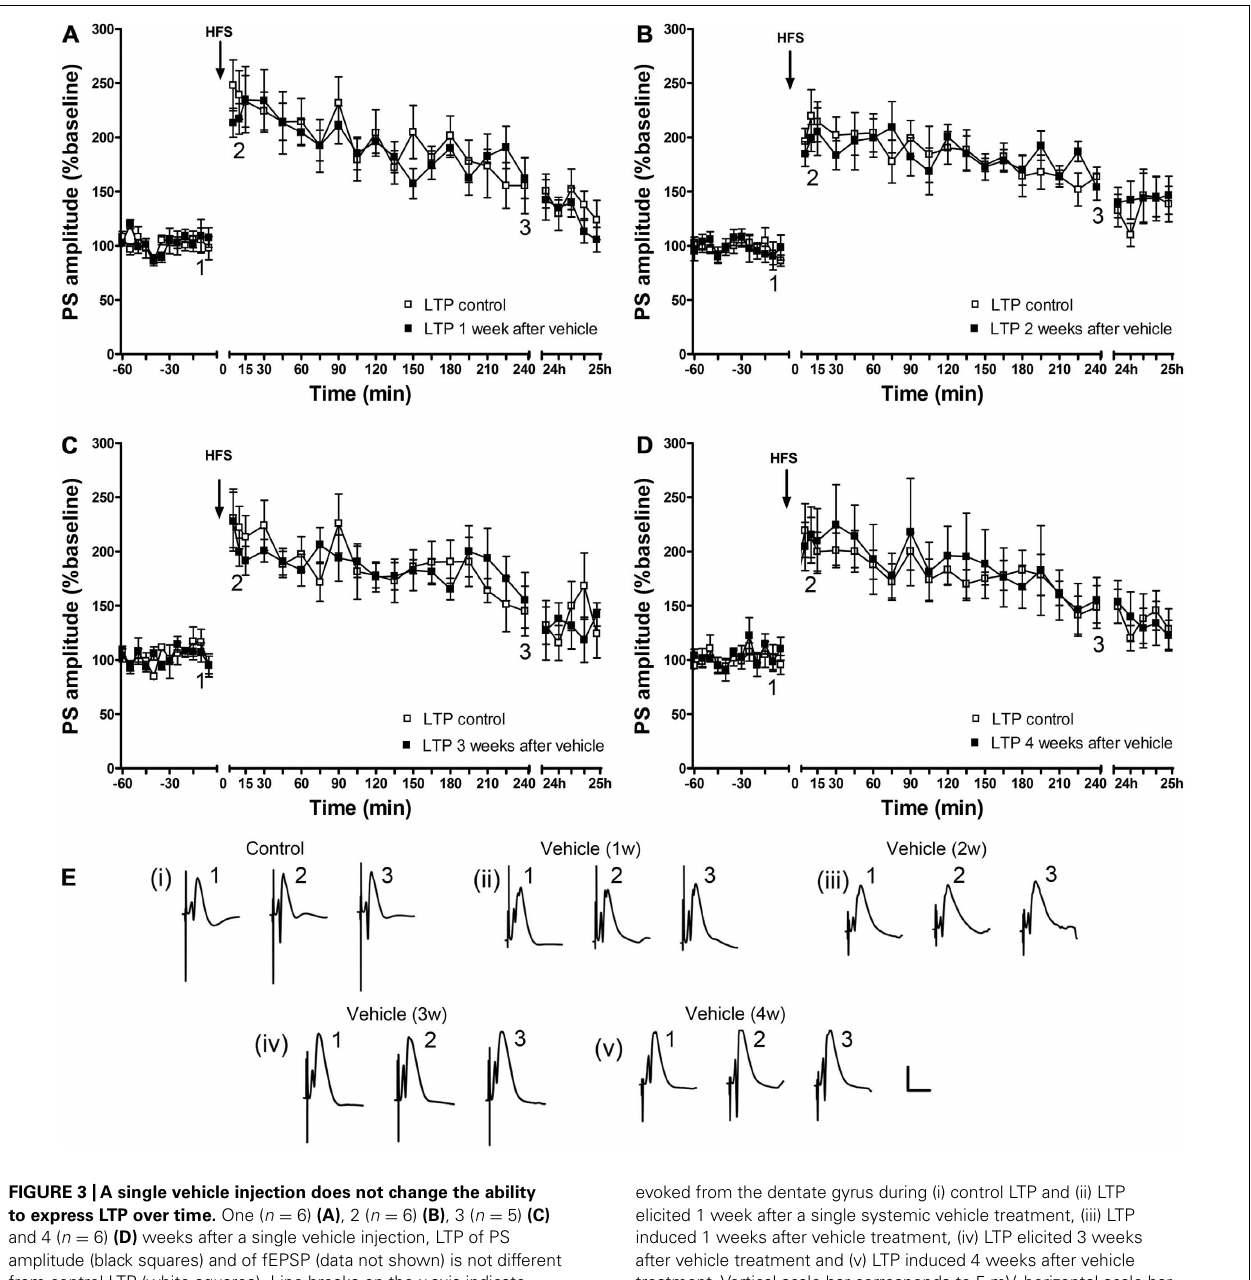
FIGURE 3 |A single vehicle injection does not change the ability to express LTP over time. One ( n = 6) (A) , 2 ( n = 6) (B) , 3 ( n = 5) (C) and 4 ( n = 6) (D) weeks after a single vehicle injection, LTP of PS amplitude (black squares) and of fEPSP (data not shown) is not different from control LTP (white squares). Line breaks on the x-axis indicate change in time-scale. (E) Original analog traces show field potentials